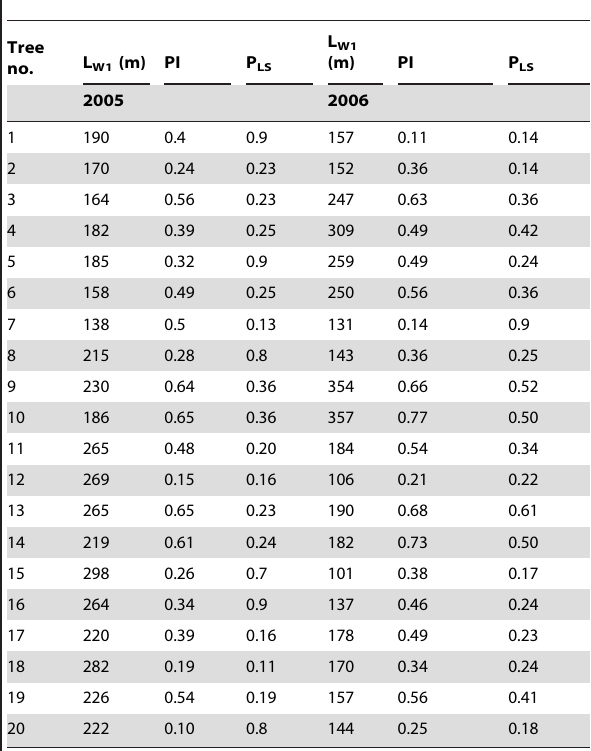
Table 1. Characterization of the 20 peach trees monitored in 2005 and 2006: total length of 1-yr old wood before winter pruning (L W1 ), fraction of L W1 pruned (PI) and fraction of buds developing as long shoots (P LS